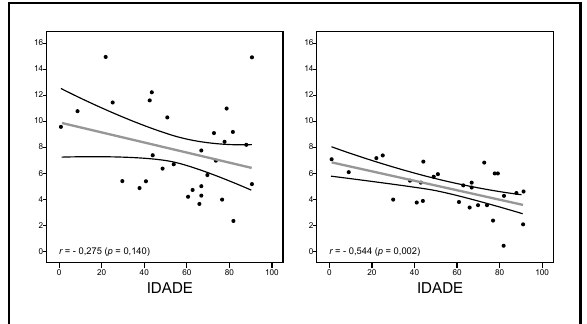
Figura 2 – Diagrama de dispersão da média de melanócitos segundo a idade nas áreas fotoexposta e fotoprotegida r: correlação de Pearson. Figura 4 – Confluência de melanócitos. Hematoxilina e eosina